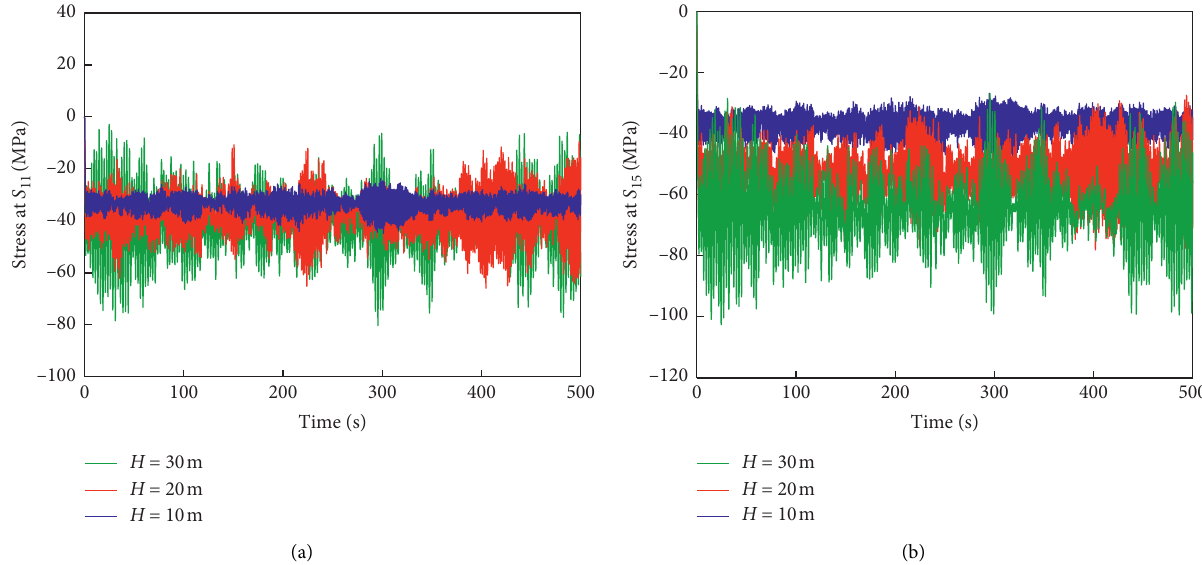
Figure 15: Comparison of stress on seabed cross section with different water depth: (a) time histories of stress at S stress at S 15 ( v � 36cm/s, h � 8cm, σ � 1.0